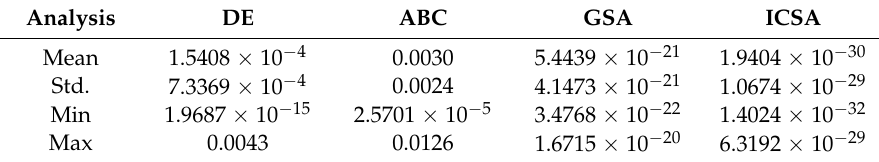
Table 4. Results of approximate circuit model ( Cos t AM ) , for motor 1.